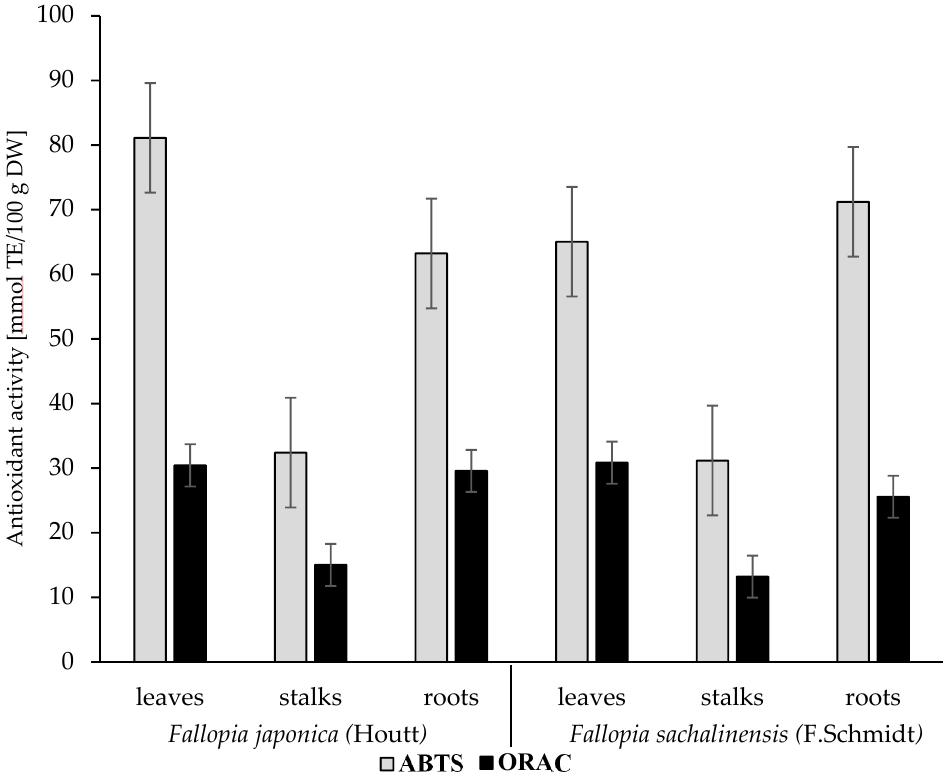
Figure 2. Antioxidative activity determined with in vitro assays: ABTS and ORAC, in wild Fallopia japonica (Houtt) and Fallopia sachalinensis (F.Schmidt) leaves, stalks, and roots (mmol TE/100 g DW).